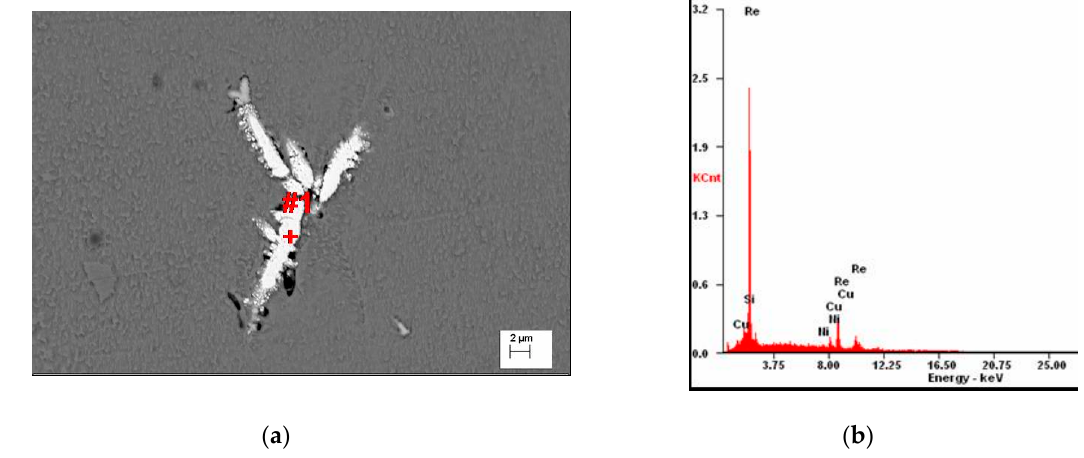
Figure 6. Microstructure of Cu–2Ni–1Si-0.6Re, initial state ( a ), EDS analysis in point #1 of elements mass concentration, %: Si 3.22; Re 86.1; Ni 1.9; Cu 8.78 ( b ).